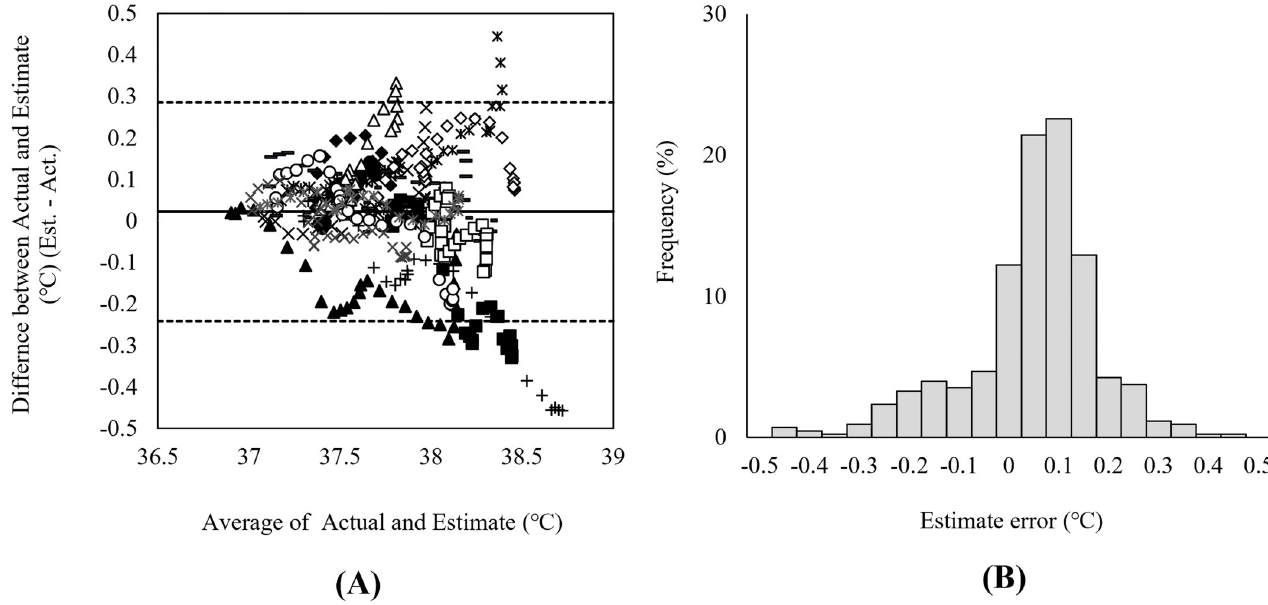
Fig 5. Bland–Altman plot for all participants indicating the bias (solid line) and ± 1.96SD (dashed line). (A) Bias ± SD = 0.023 ± 0.13. Different scatter plot markers were used for each participant. (B) Normalized histogram of developed model error for all validation data.